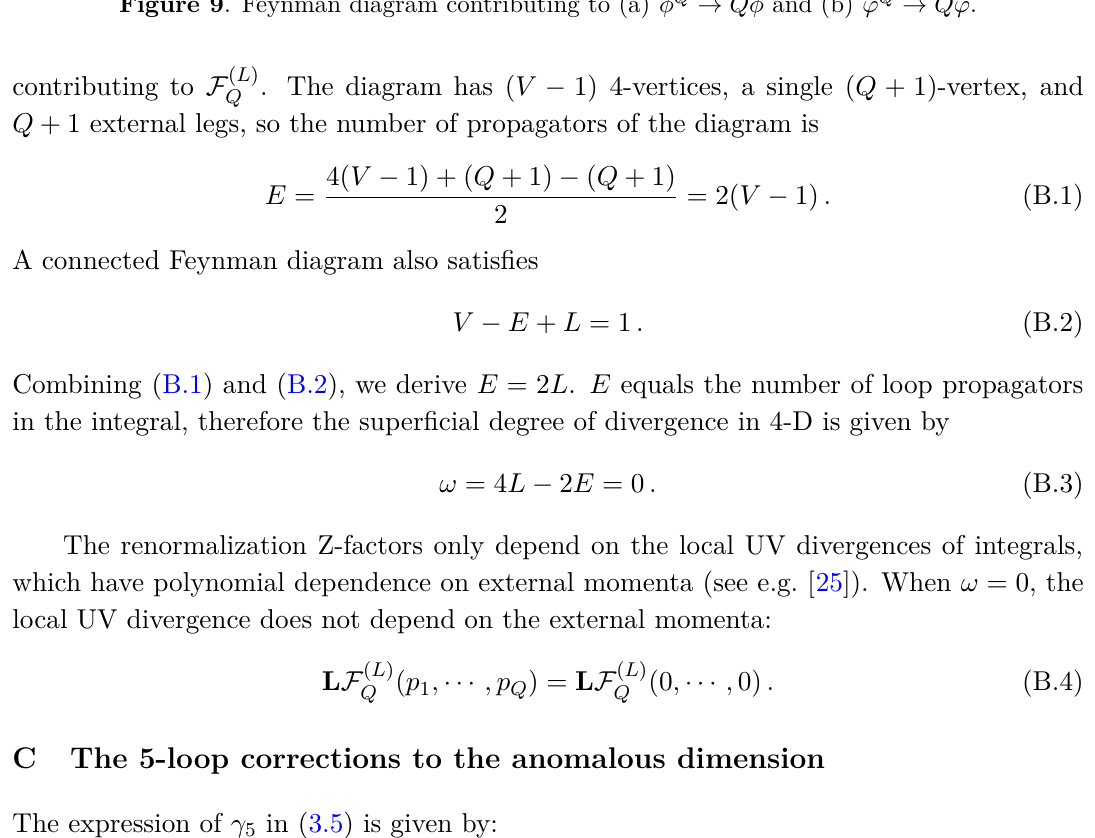
Figure 9 . Feynman diagram contributing to (a) φ Q → Qφ and (b) ϕ Q → Qϕ